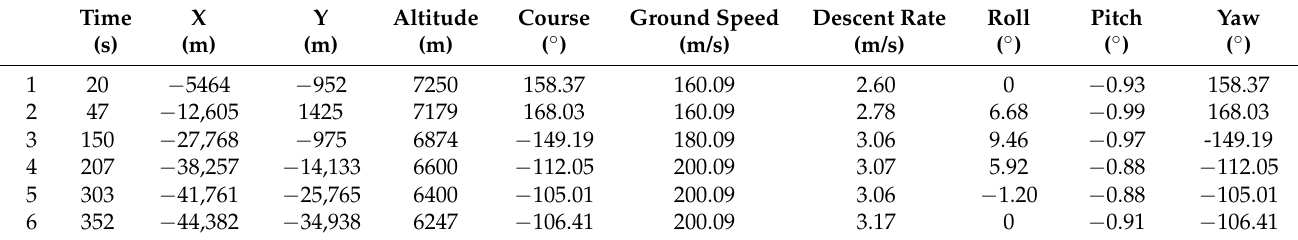
Table 3. Trajectory data for proposed tactical diversion.